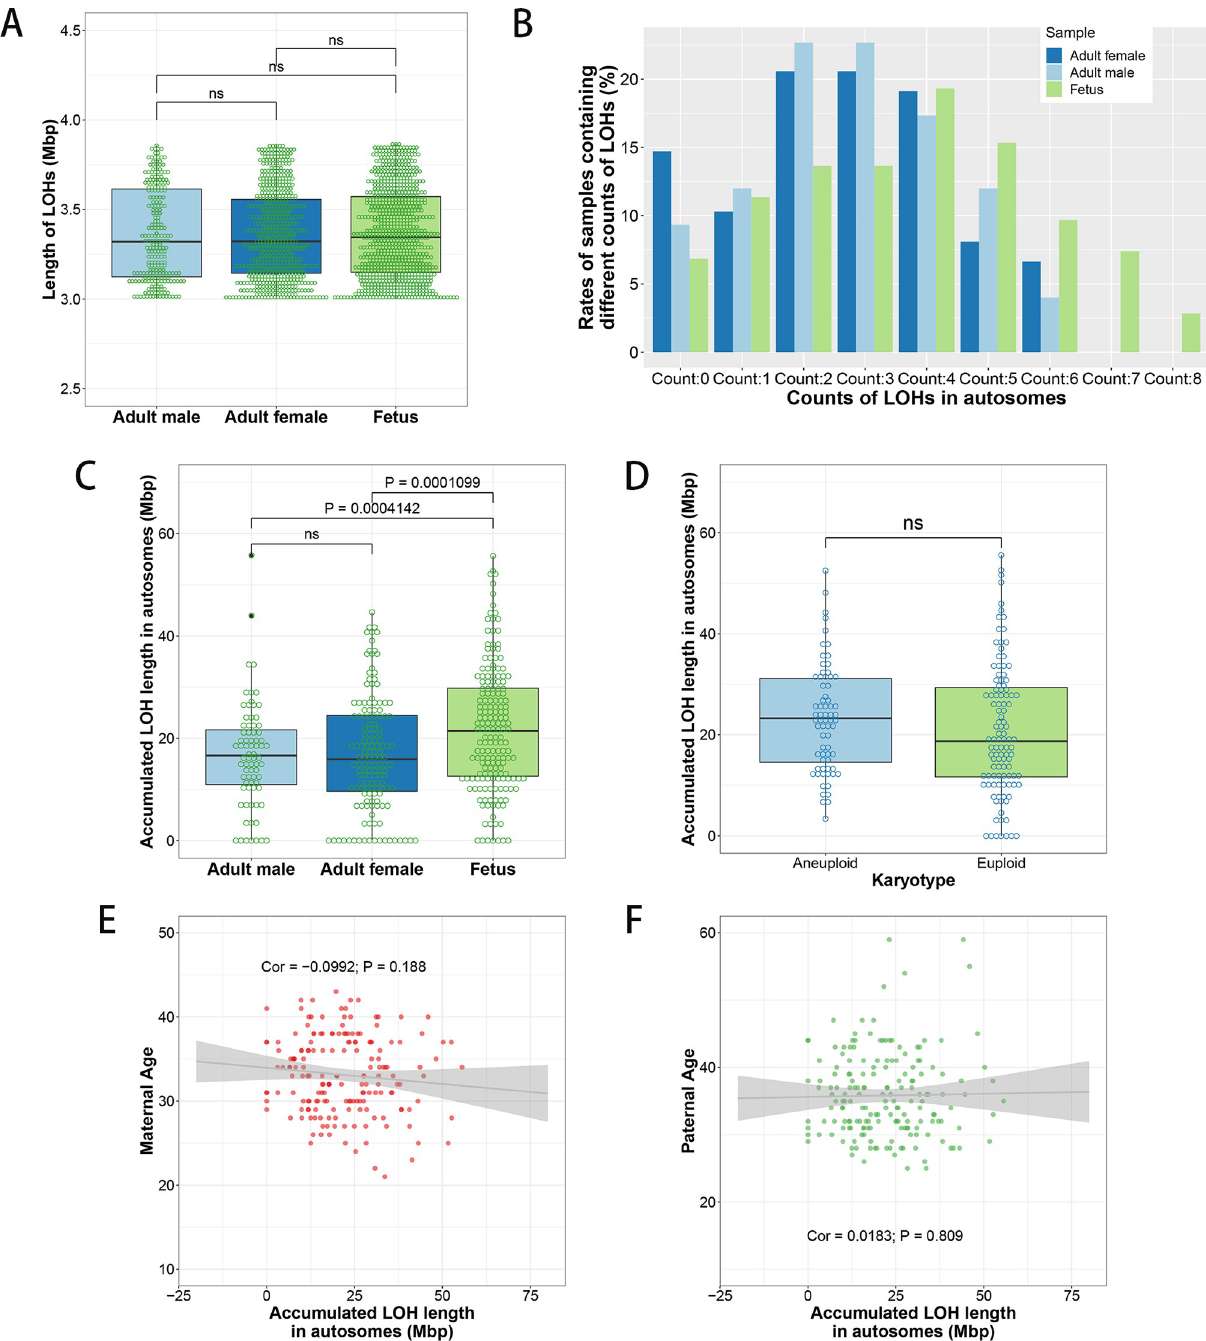
Fig 3. Statistics of autosomal LOHs in ART-aborted fetuses and ART adults. (A) Boxplot of lengths of autosomal LOHs of male/female patients and the ART-aborted fetuses. (B) Rates of samples containing different number of autosomal LOHs. (C and D) Accumulated lengths of autosomal LOHs in each sample grouped by adult males, adult females and aborted fetuses (C) or by aneuploid and euploid of the aborted fetuses (D). (E and F) The association analysis of accumulated autosomal LOH lengths with maternal ages (E) and paternal ages (F). ‘ns’, P values of t test > 0.05. ‘Cor’, correlation